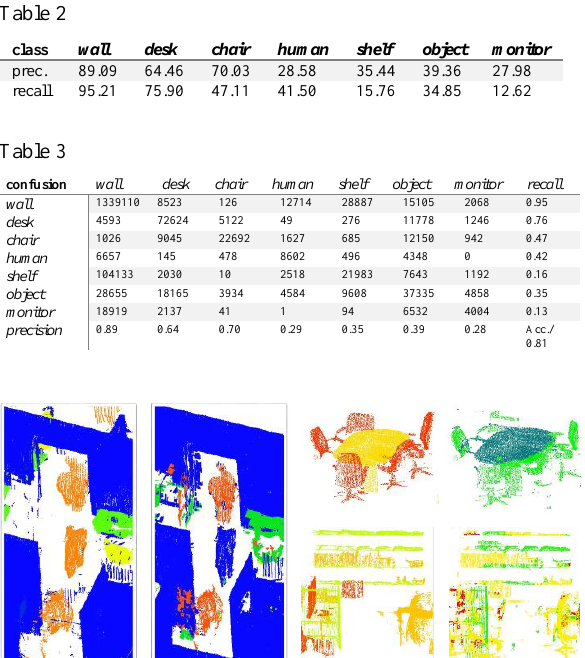
Figure 5. Particular details from segmentation results. Left hand side of the image pairs are the ground truth, while the right hand sides are the CNN predictions. a) of the 3 human in the scene, two of them correctly labelled while the one in the middle is mistaken as a wall; b) the table in the meeting room is generally segmented with surrounding chairs, despite been trained only from desk examples; c) shelves are fairly detected while monitors are largely missed.